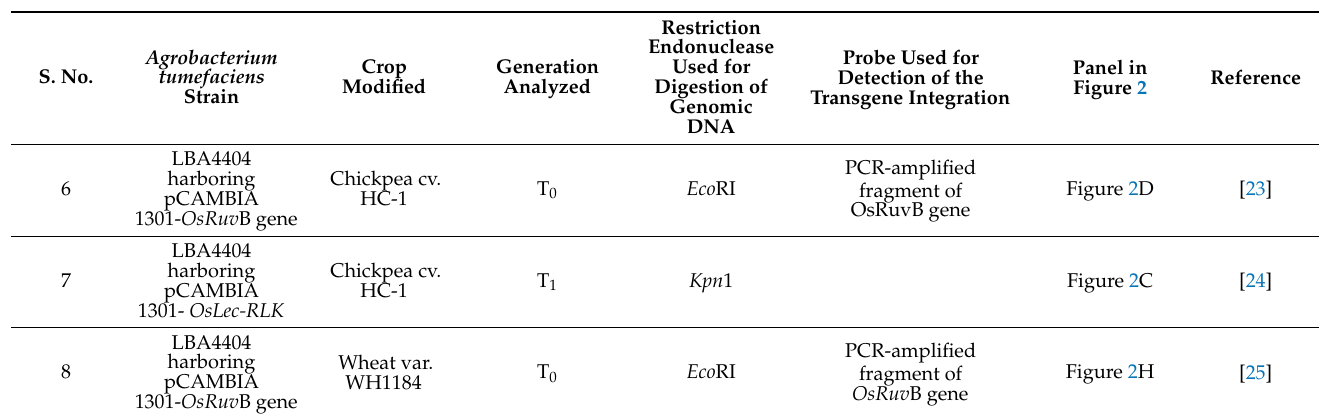
Table 3. Details of Southern hybridization analysis conducted in transgenic lines developed using the reported